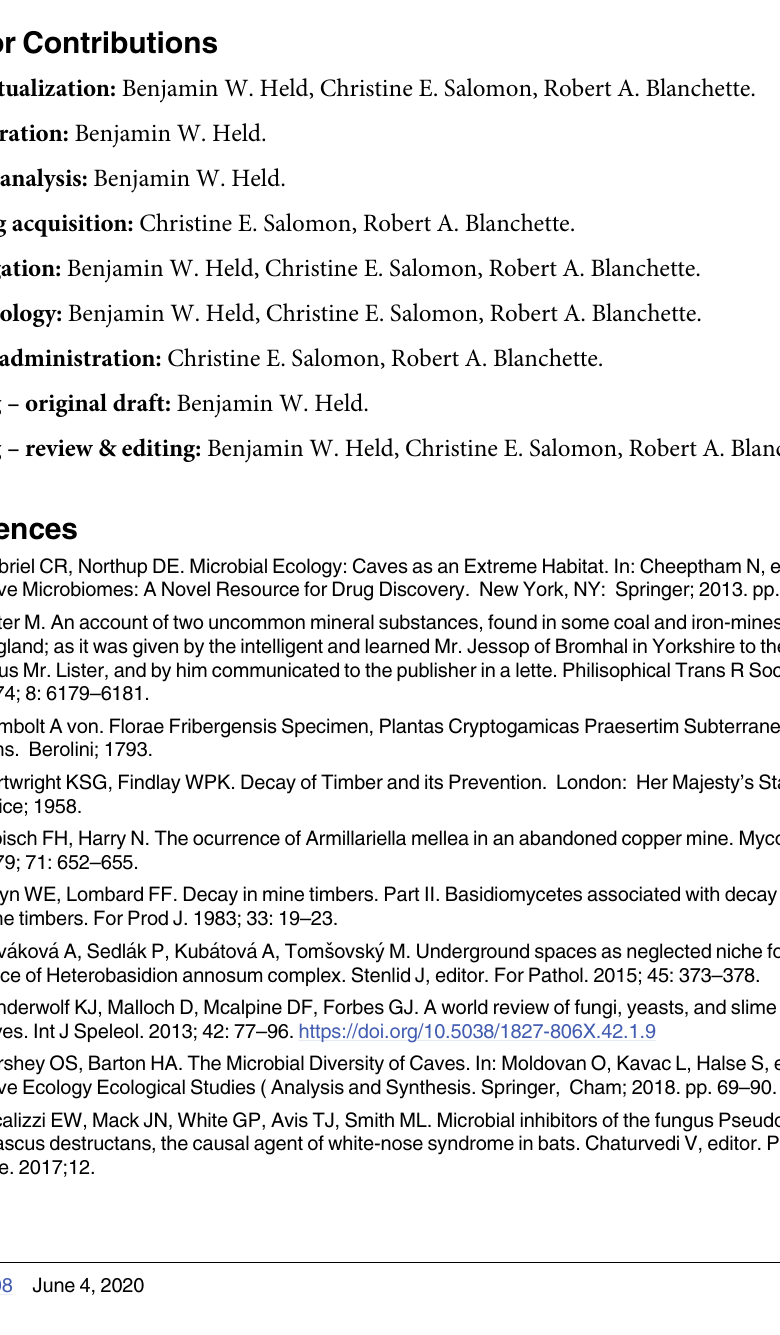
S1 Table. Table showing best BLAST % identity, numbers of isolates recovered from each mine level, and GenBank # for each